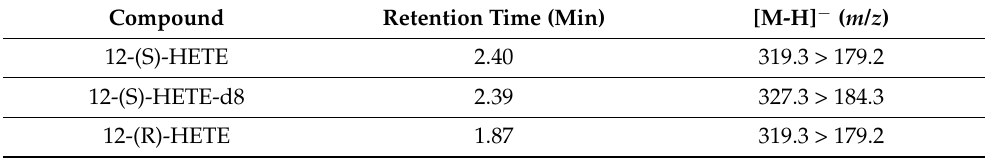
Table 3. Chiral LC-MS/MS analysis of 12(S) and 12(R)-HETE enantiomers during suckling